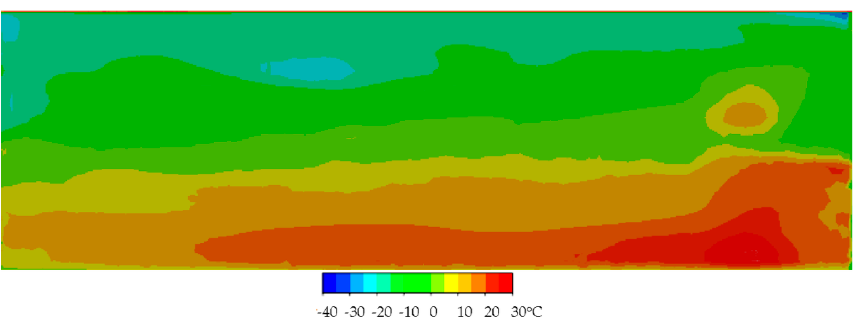
Figure 16. Map of the divergence of temperature measurement for experiment #03 (after 200 s of simulation).